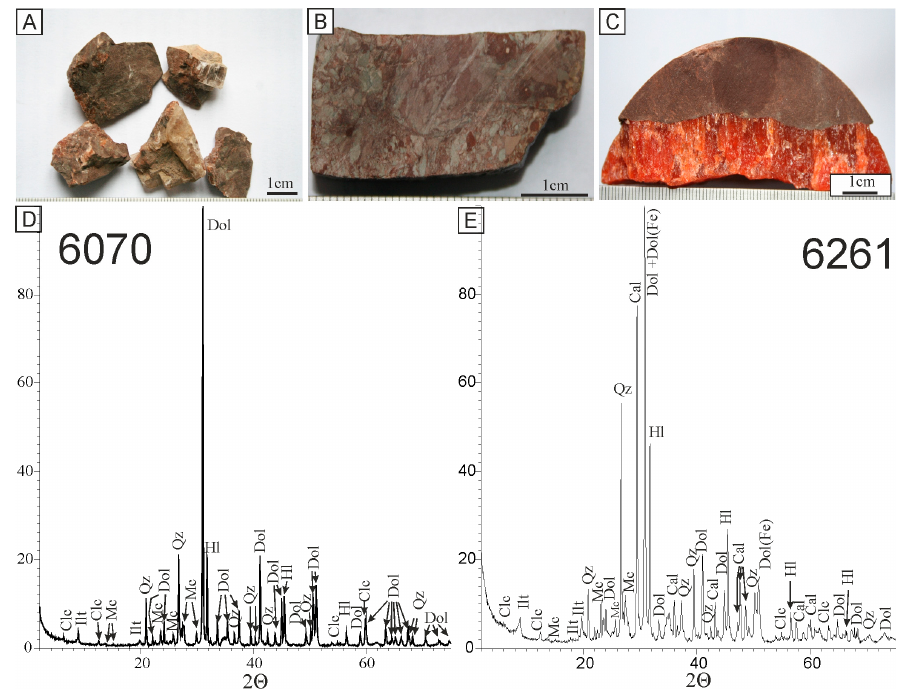
Figure 9. ( A ) Fragments of carbonates intercalations with halite crystals. ( B ) The polished side of carbonates intercalations shows brecciated fabric. ( C ) Example of red fibrous halite vein cutting through carbonates. ( D , E ) X-ray diffraction pattern for sample of intercalations (Dol—dolomite, Dol(Fe)—ferroan dolomite, Cal—calcite, Qz—quartz, Hl—halite, Clc—clinochlore, Mc—microcline, Ilt—Illite).